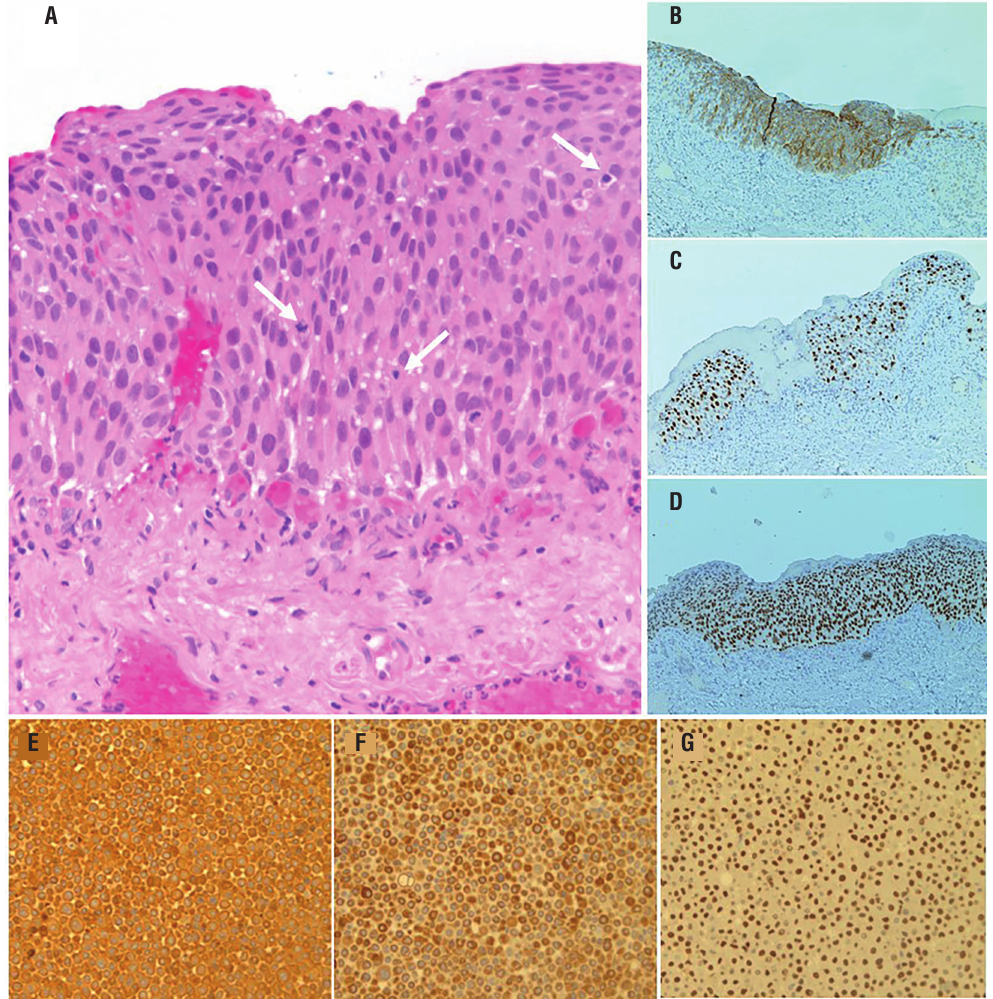
Figure 1 - Histopathology of the bladder after TURBT: (A) H-E stain (20x) with high-grade urothelial CIS. (B) Strong full thickness expression of cytokeratin 20. (C) High proliferative activity measured by Ki67 index. (D) Strong and diffuse overexpression of p53 protein (positivity was seen throughout urothelial thickness). Immunochemistry after fine